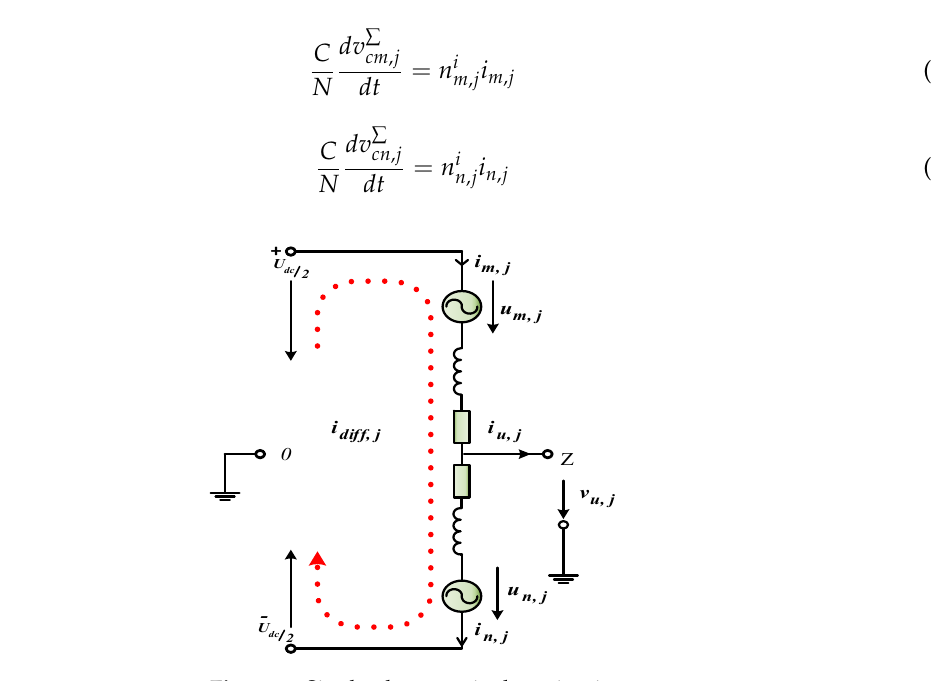
Figure 3. Single phase equivalent circuit.